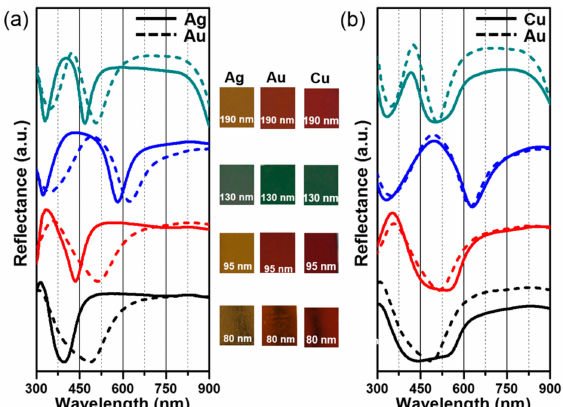
Figure 6. Absorption resonance behaviors as a function of pore widening time ( t W ) for QU-AAO based plasmonic structures. ( a ) The reflectance spectra for di ff erent widening times, where the dot line shows the position of absorption resonance peaks; ( b ) The resonance peak shifts toward shorter wavelength (blue shift) as the pore size increases (longer widening time). The insets showed FE-SEM images of the top view for the silver-coated QU-AAO structures. The scale bar is 100 nm.